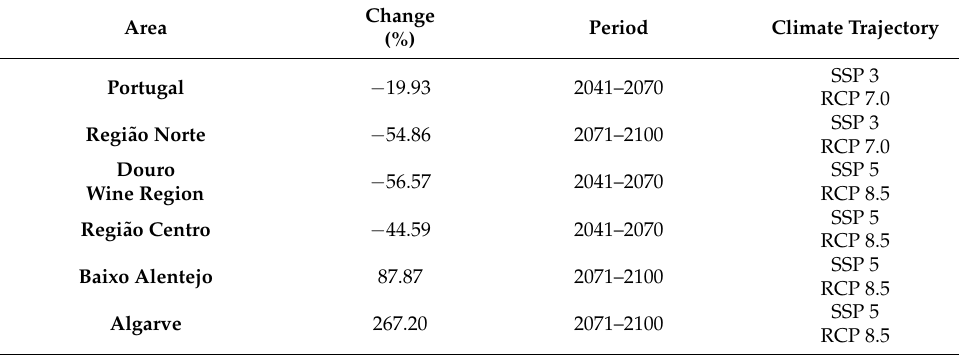
Figure 3. Predictions (EPSG:3035) for the 2011–2040 period; the figure follows the style of Figure 2. ( Left panels ) with irrigation, ( right panels ) without irrigation, ( top panels ) SSP3-7.0 climate trajectory, ( bottom ) SSP5-8.5 climate trajectory. Table 1. Summary of the most extreme climate change scenario effects under continued irrigation on the suitable area relative to the baseline period (1981–2010) across Portugal and the five focal